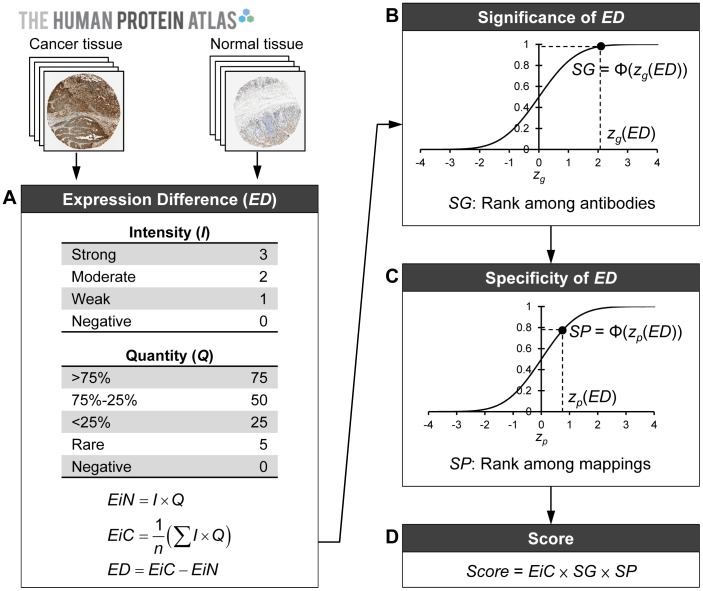
Procedure for determining the score of an antibody in relation to a mapping of interest.(A) Initially, the protein expression levels and the expression difference (ED) between cancer tissue and normal tissue for all antibodies covering all mappings are calculated. (B) The significance of the target ED with respect to the mapping of interest is determined by a cumulative z distribution. (C) The specificity of the target ED with respect to the mapping of interest is determined by another cumulative z distribution. (D) The final score of the antibody with respect to the mapping of interest is determined on the basis of its protein expression level in cancer tissue and the significance and specificity of its ED.